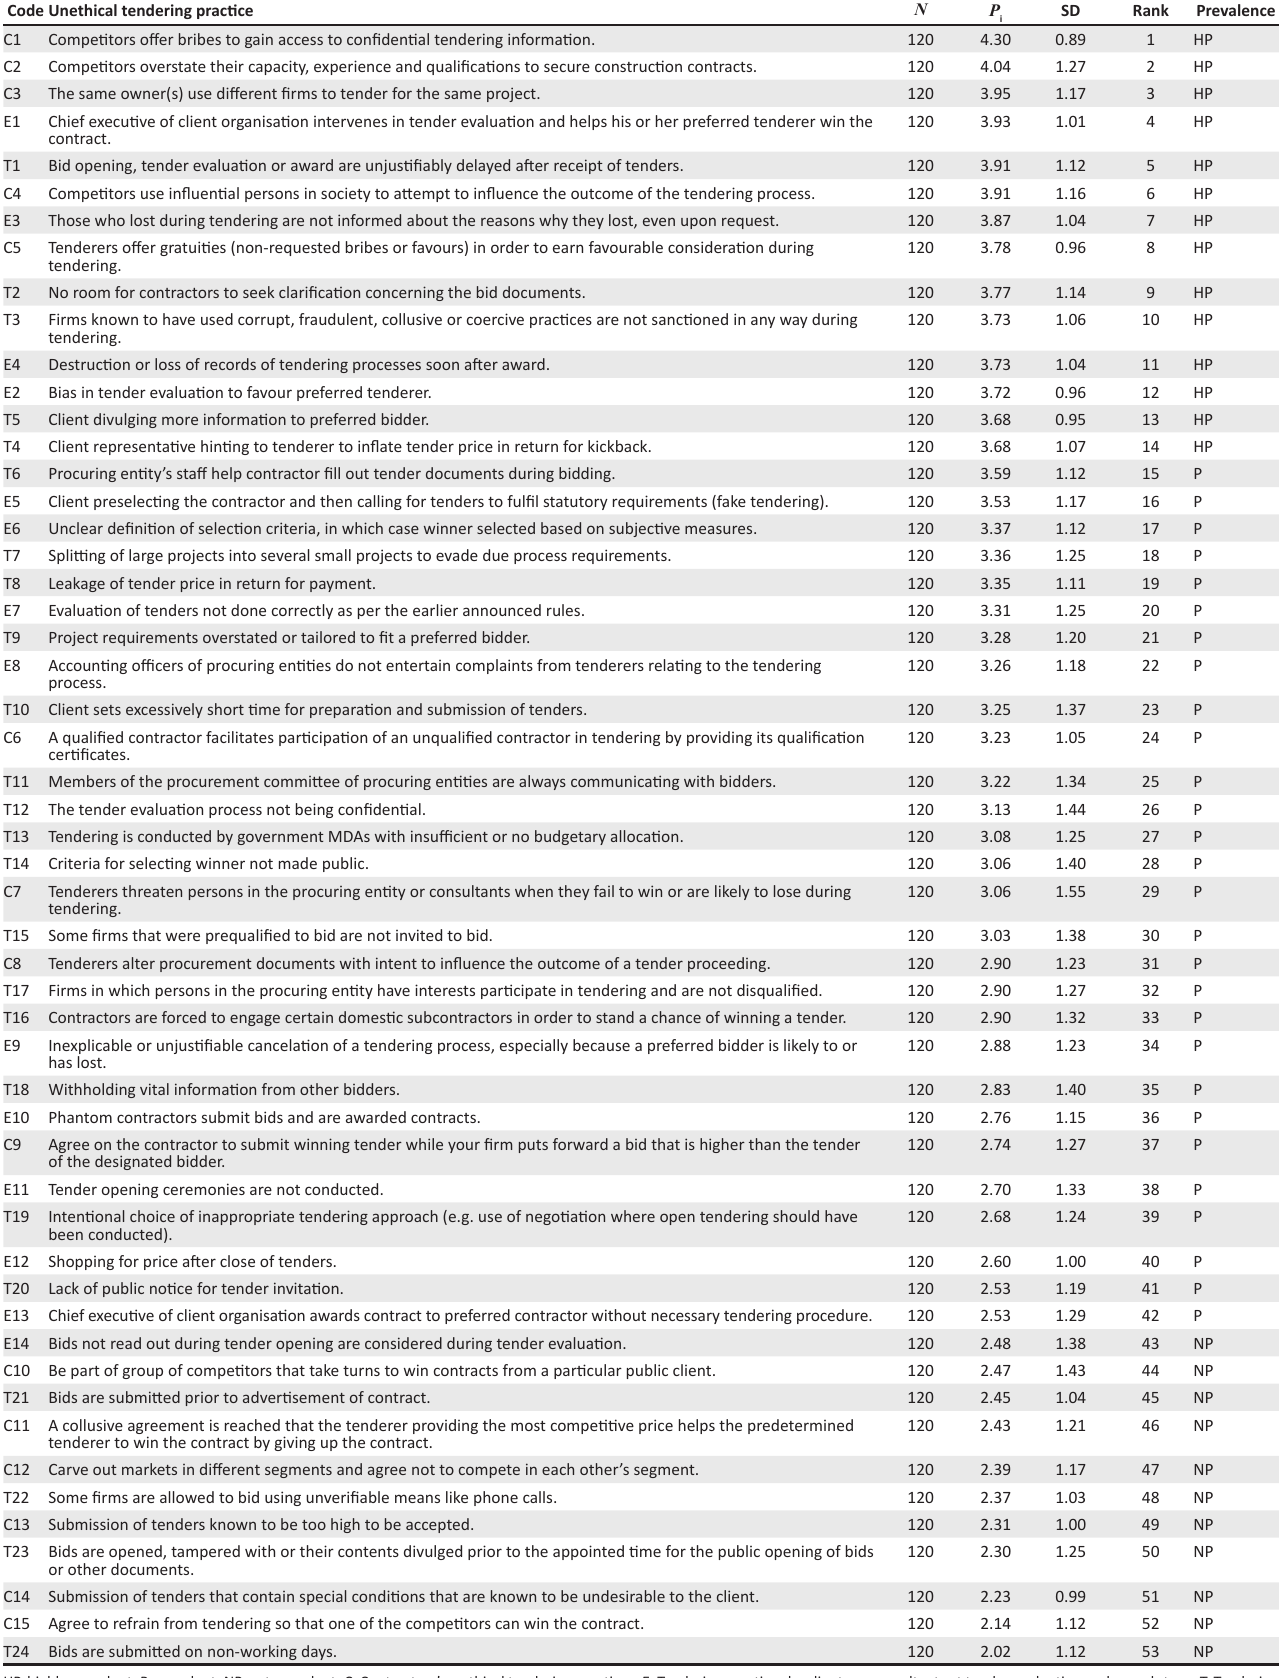
TABLE 6: Overall ranking of unethical tendering practices in the research area. Code Unethical tendering